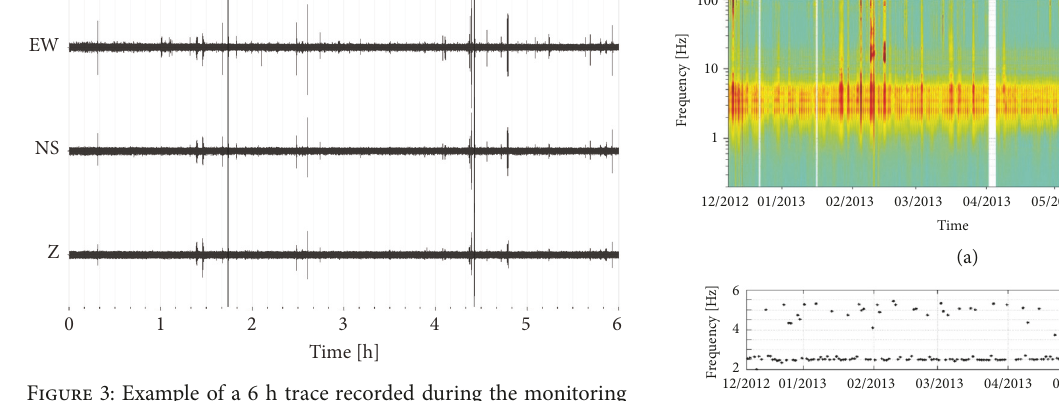
Figure 3: Example of a 6 h trace recorded during the monitoring period at TOR1 showing vibrations in three components (EW, NS, and vertical Z.)